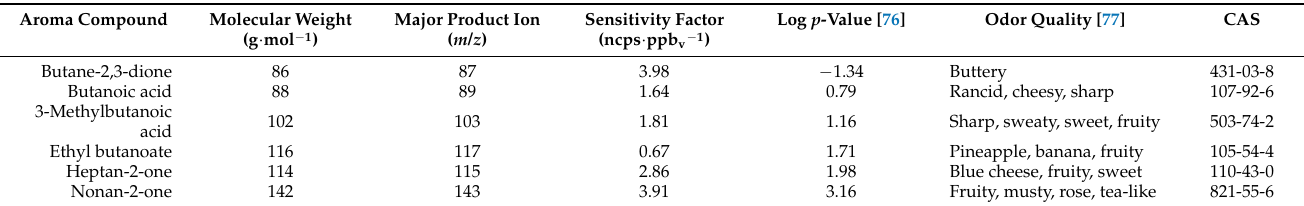
Table 3. Aroma compounds and their physicochemical